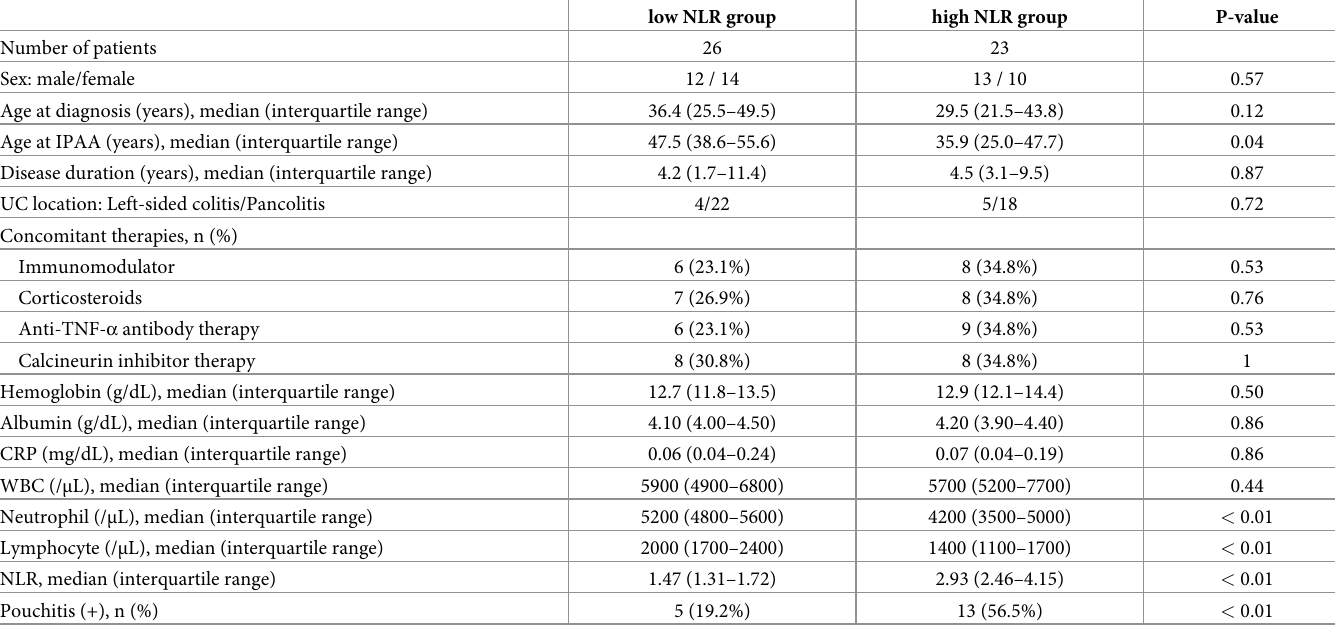
Table 3. Comparison between the low NLR group and high NLR group.